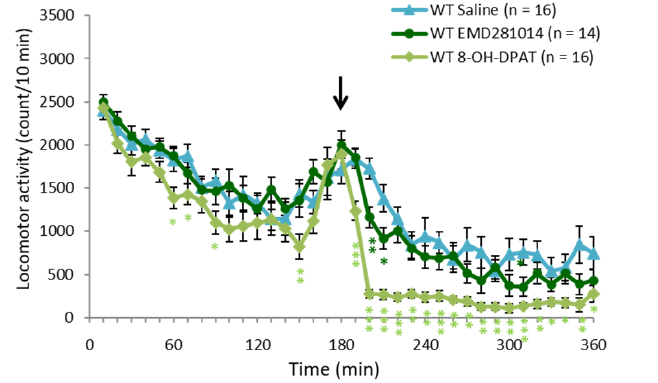
Figure 4. Different effects of 5-HT and 5-HT 2A receptor activation on hyperactivity in DD mice. ( a , b ) Changes in locomotor activity in ( a ) WT and ( b ) DD mice after EMD281014 (5-HT 2A receptor antagonist) and 8-OH-DPAT (5-HT 1A receptor agonist) administration. The arrows indicate the drug administration time. * p < 0.05, ** p < 0.01, *** p < 0.001, compared with saline (Student’s t -test). The graphs show the number of animals per group. The data are expressed as mean ± SEM. WT, wildtype mice; DD, dopamine-deficient mice; 8-OH-DPAT, 8-hydroxy-2-dipropylaminotetralin hydrobromide.